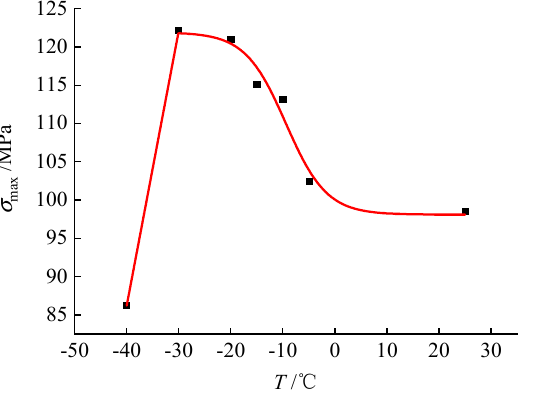
Figure 3. Dynamic compressive strength of water-saturated red sandstone at different temperatures.